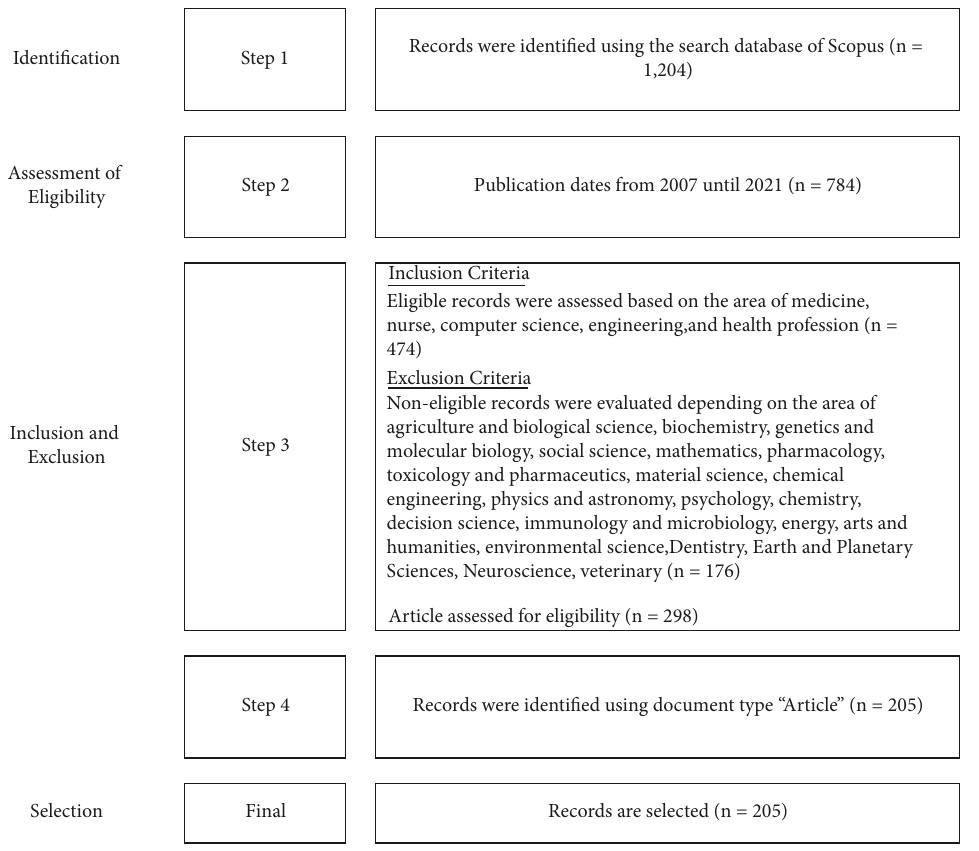
Figure 1: The steps of searching and selecting articles.